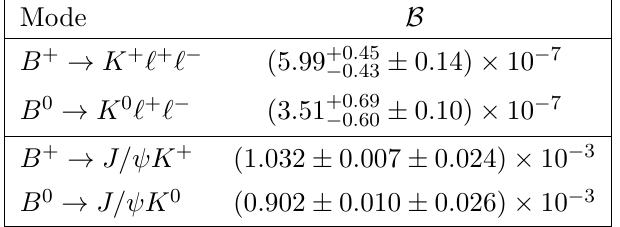
Table 2 . Branching fraction for B → K‘ + ‘ − and B → J/ψK